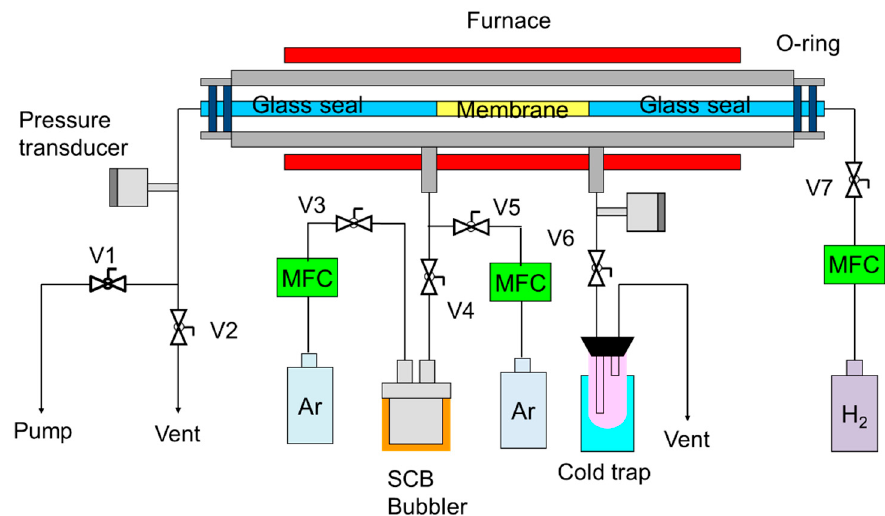
Membranes 2019 , 9 , x FOR PEER REVIEW Figure 2. Counter-di ff usion chemical vapor deposition apparatus for SiC membranes. Figure 2. Counter-diffusion chemical vapor deposition apparatus for SiC membranes.